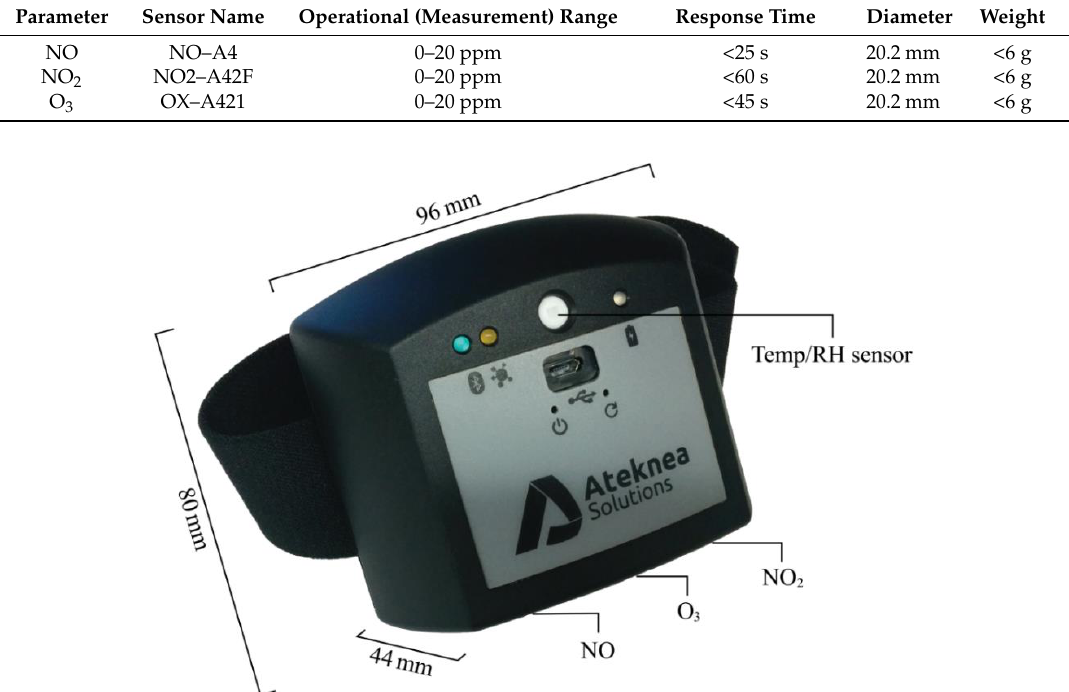
Figure 1. Little Environmental Observatory (LEO) portable sensor system.